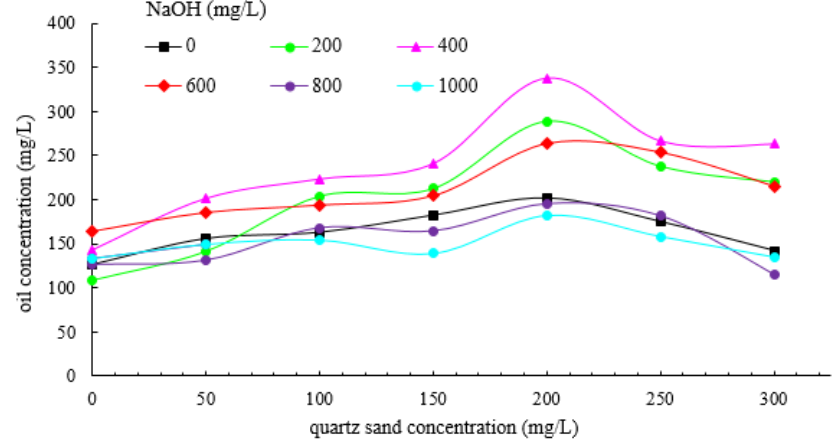
Figure 3. The synergetic effect of alkali and quartz sand particles on oil–water separation (polymer concentration 500 mg/L, surfactant concentration 200 mg/L).